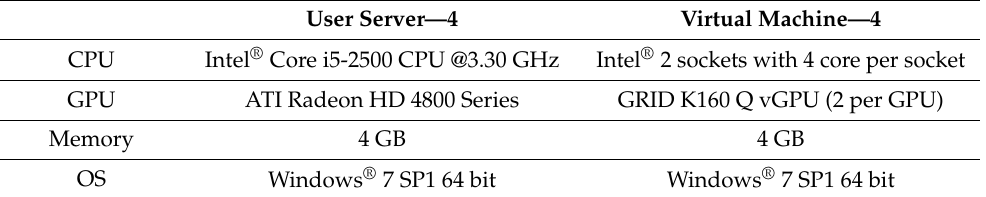
Table 14. Condition 4 of test